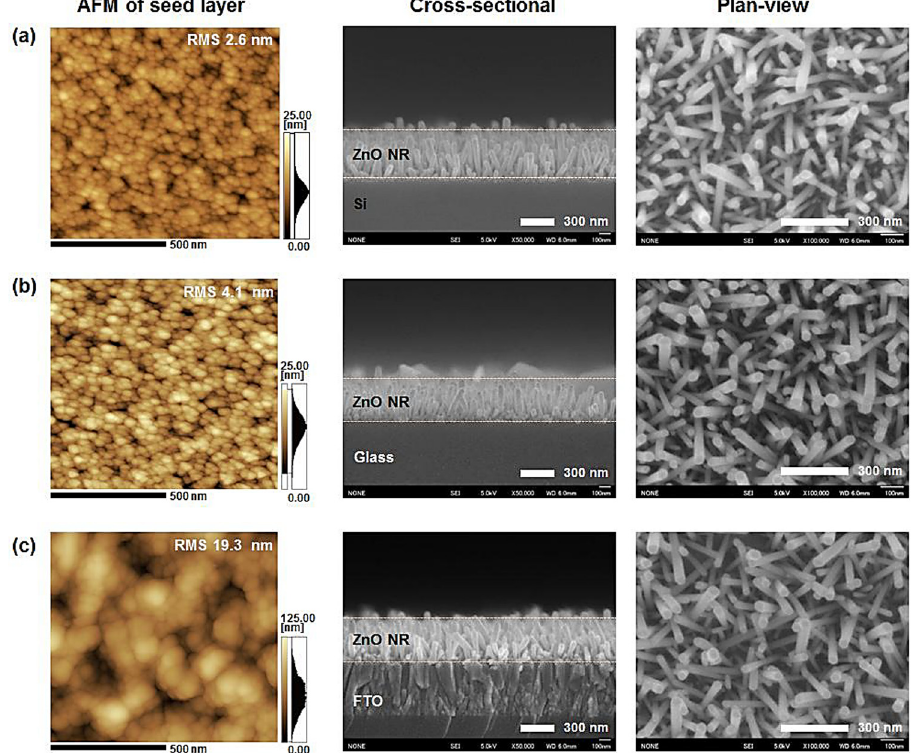
Figure 8. AFM images of the seed layer annealed at 350 °C and FESEM images of ZnO NRs grown for 3 h on different substrate materials: ( a ) silicon, ( b ) glass, and ( c ) FTO/glass. Reprinted from ref. [126].